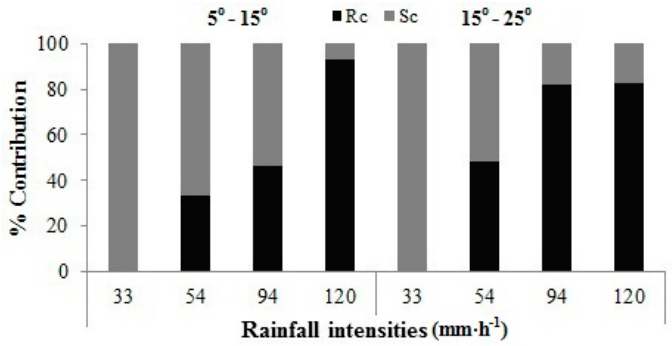
Figure 2. Rainfall (Rc) and slope (Sc) contributions for runoff losses under different rainfall intensities with increasing slope steepness from 5° to 15° and 15° to 25° in un ‐ mulched soil. In mulched soil, the runoff losses increased with increasing rainfall intensity and the slope steepness. The results, in Table 1, indicate that the maximum runoff of 58.4 mm ∙ m − 2 was recorded for the rainfall intensity of 120 mm ∙ h − 1 at the 25° slope level. Under rainfall simulations of 33 mm ∙ h − 1 , runoff was completely stopped, while negligible losses occurred at 15° and 25° slope during rainfall intensity of 54 mm ∙ h − 1 . The results, in Figure 3, indicate that Sc for runoff losses was >50% during an increase in slope steepness from 5° to 15° under rainfall simulation of 54, 94 and 120 mm ∙ h − 1 . However, Sc was >50% with an increase in slope steepness from 15° to 25°, except for rainfall simulations of 120 mm ∙ h − 1 . These results suggest that mulch tended to retard the flow velocity, and reduced the quantity of water available for runoff losses, thus slope becomes an important factor influencing the runoff generation in mulched conditions. However, Sc values showed a decreasing trend with increasing rainfall intensity and slope steepness; this trend shows water absorbing and flow reducing capacity of mulch decreases with increasing rainfall intensity and slope steepness. Thus, Sc for runoff losses in mulched soil decreases accordingly. Because runoff on steep slopes is greater, primarily because water remains for a shorter time on the soil because of the gravity effect, and reduced water storage capacity [40].